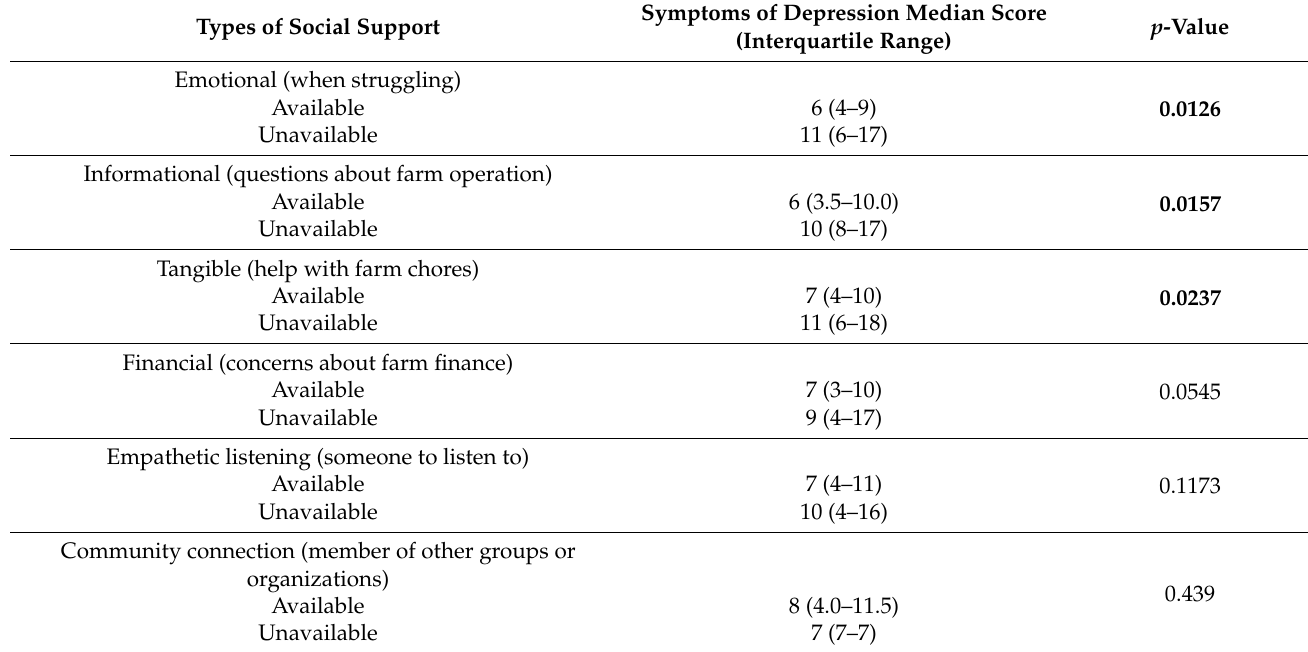
Table 6. Associations between social support availability and symptoms of depression